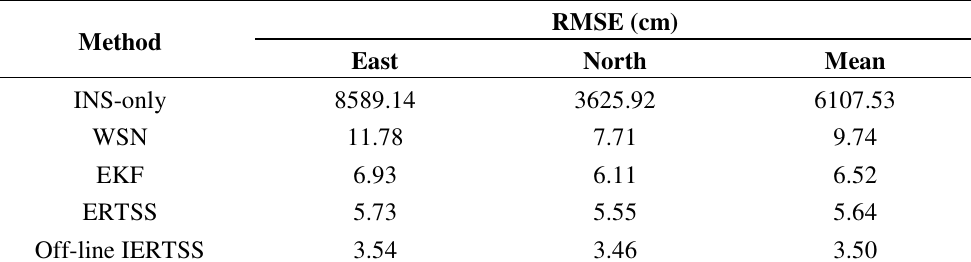
Table 3. Comparison of five estimation strategies in terms of position